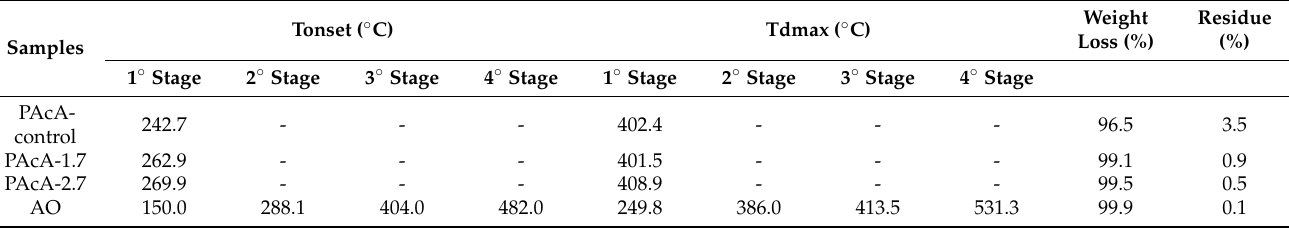
Table 5. TGA and DrTGA curves parameters of the PCL casting films and andiroba oil: degradation onset temperature (Tonset), maximum degradation temperature (Tdmax), weight loss (%), and the percentage of residues. Tonset ( ◦ C) Tdmax ( ◦ Samples